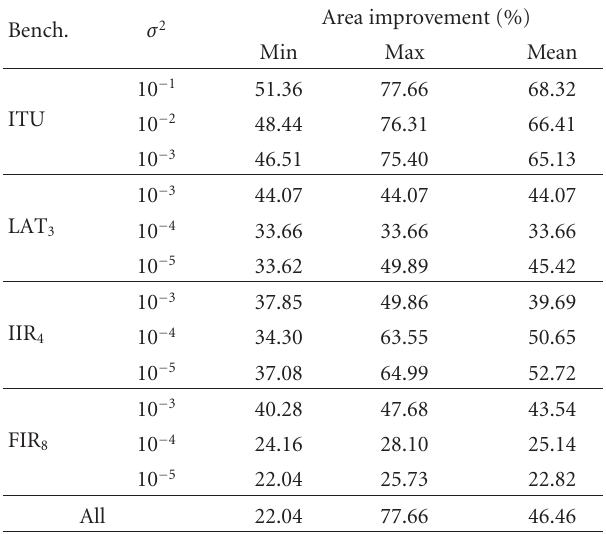
Table 3: UWL versus MWL for homogeneous architectures.